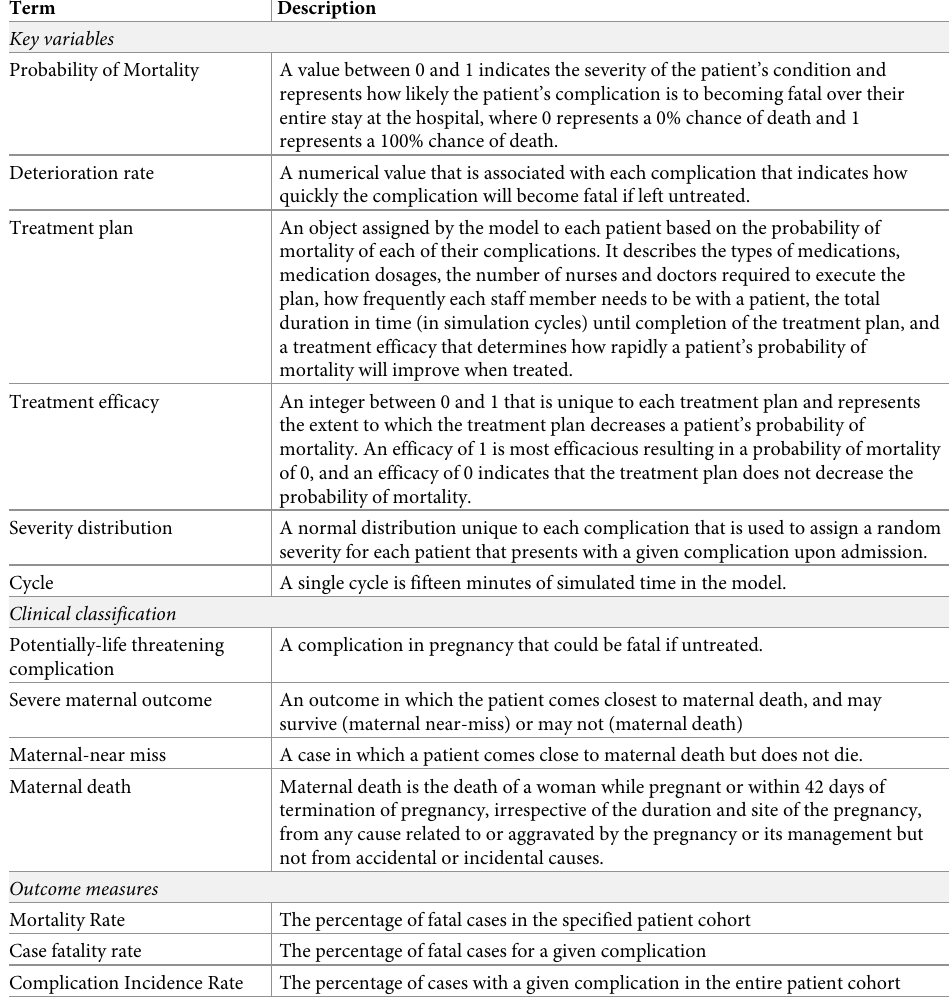
Table 1. Description of key variables, clinical classification, and outcome measures used in the